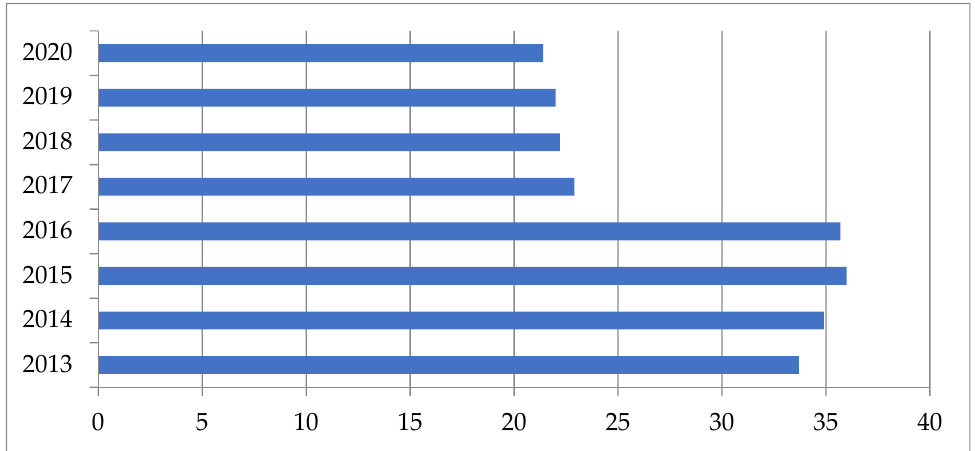
Figure 5. Dynamics of the share of working pensioners in Russia, %.